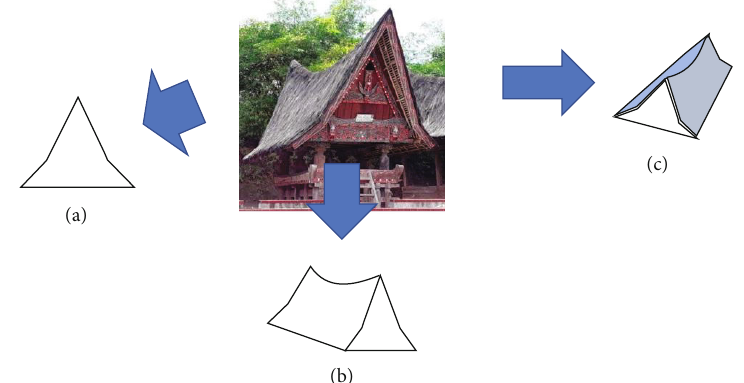
Figure 18: Batak Toba house and its house diagrams.